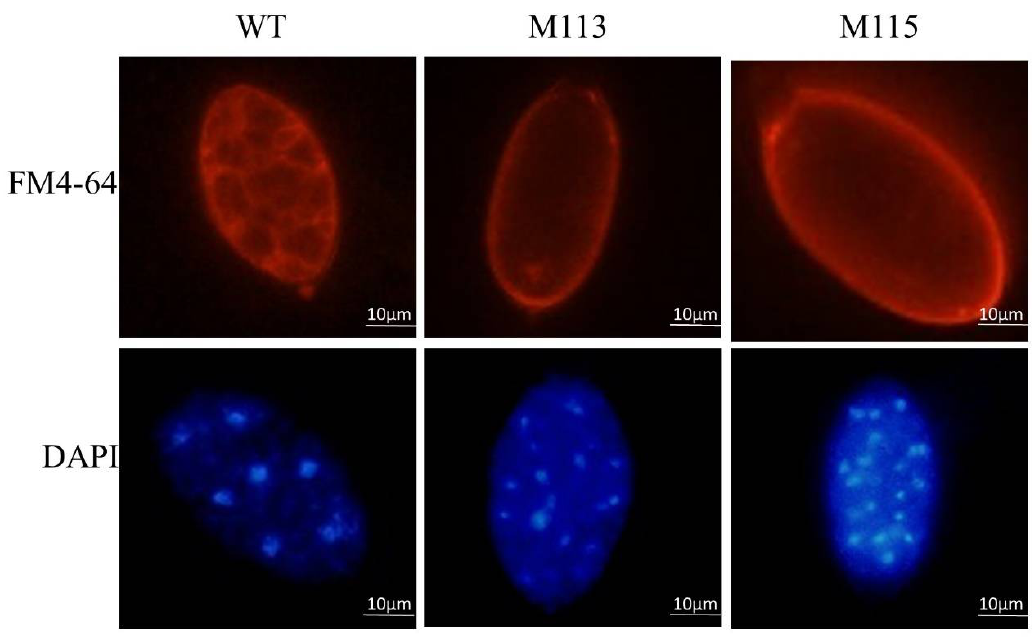
Figure 4. Assessment of nuclei distribution and cytoplasm cleavage within sporangia. The nuclei in sporangia were detected by DAPI staining. Plasma membrane stained by FM4-64. Representative microscopic images for WT (wild type) or the mutants were displayed ( n ≥ 9). Scale bar = 10 μm.